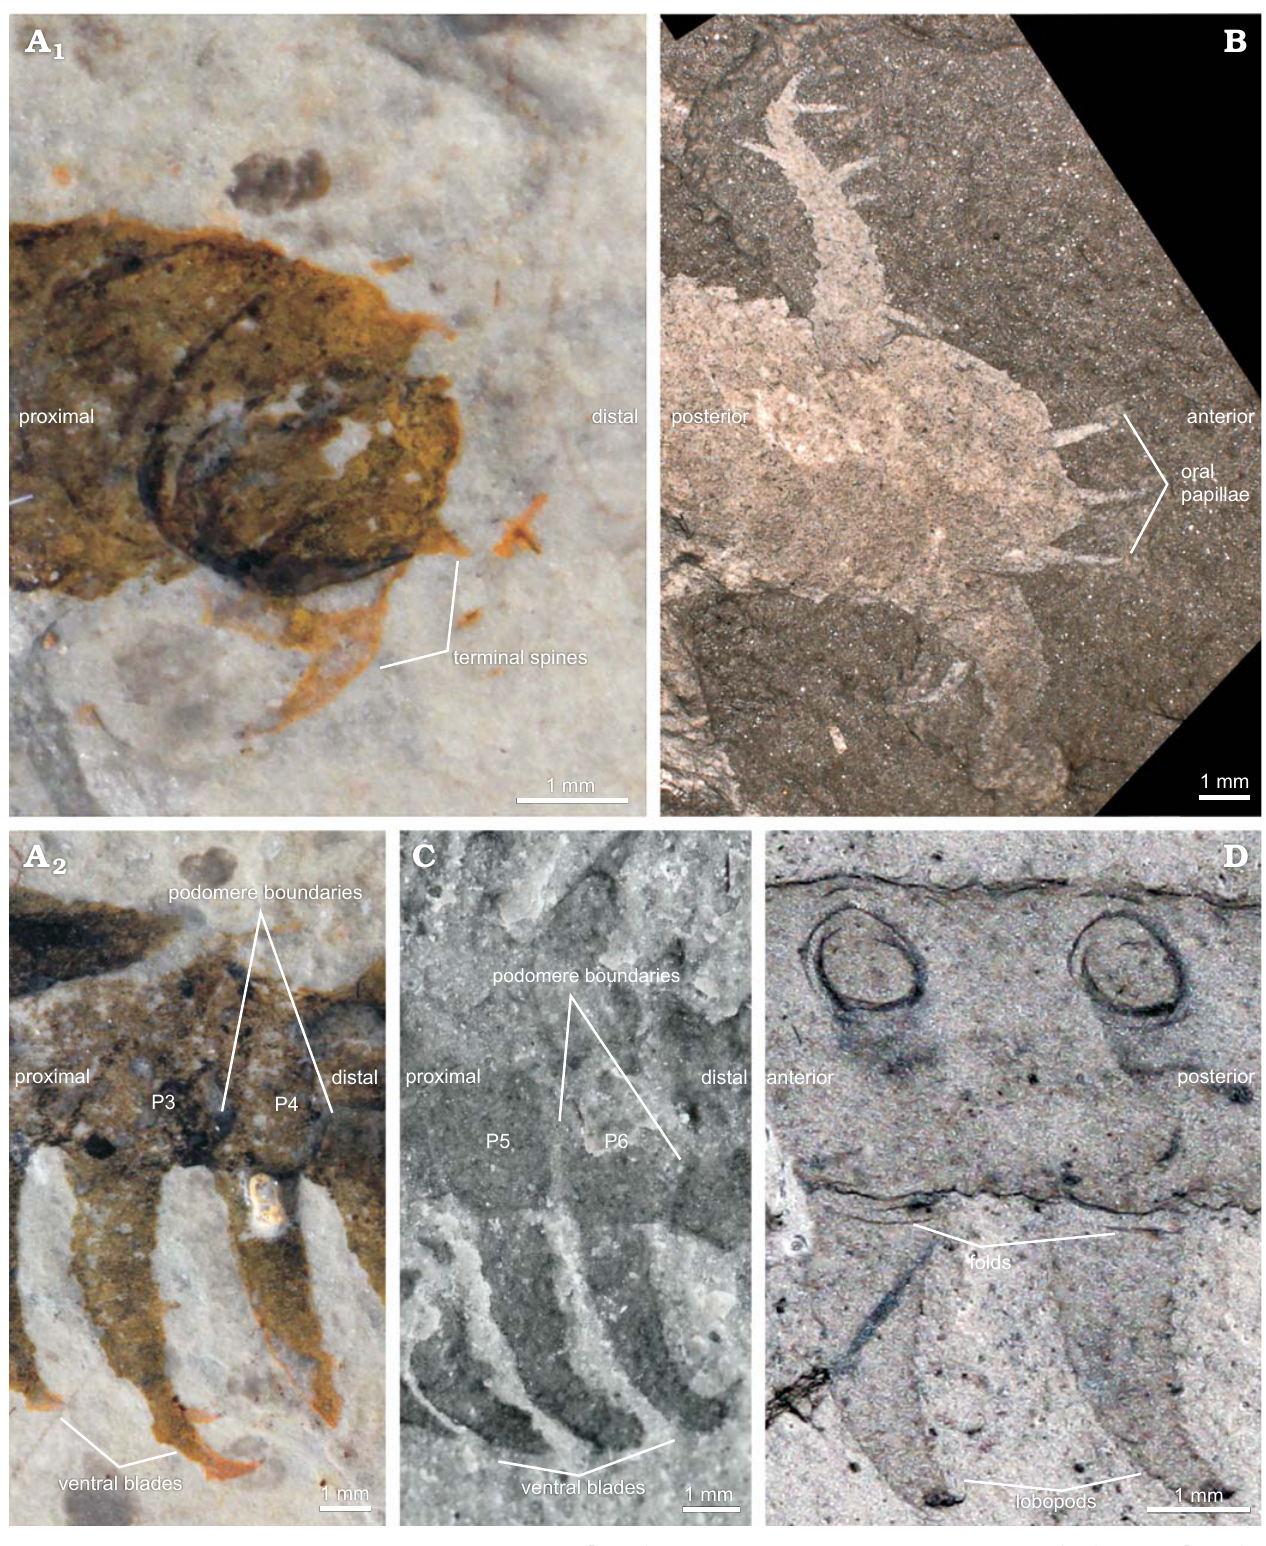
Fig. 3. Comparison between terminal spines and vetral blades of Stanleycaris and oral papillae and lobopodous limbs of Aysheaia . A . Stanleycaris sp., KUMIP 153923 from the Wheeler Formation (Cambrian Series 3, Drumian), Utah, USA; anterior end showing recurved terminal spines (A